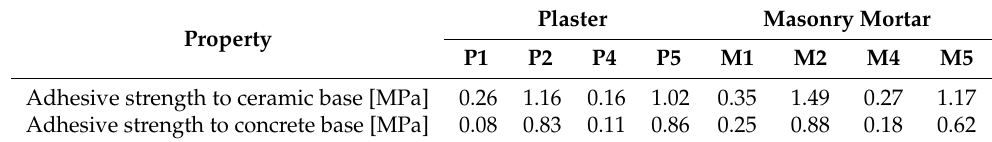
Table 11. Adhesion of mortars to base.